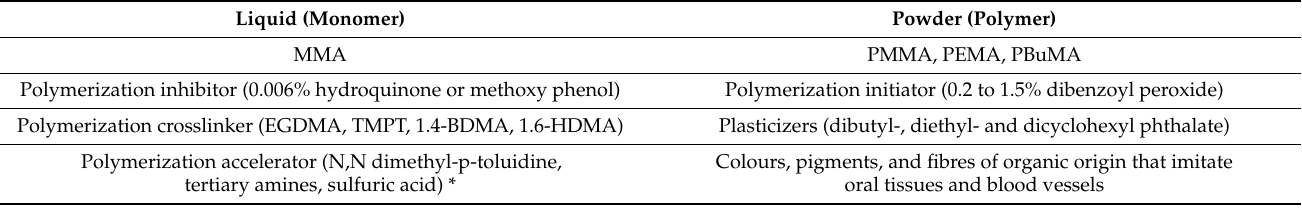
Table 1. Powder and liquid composition of conventional acrylate